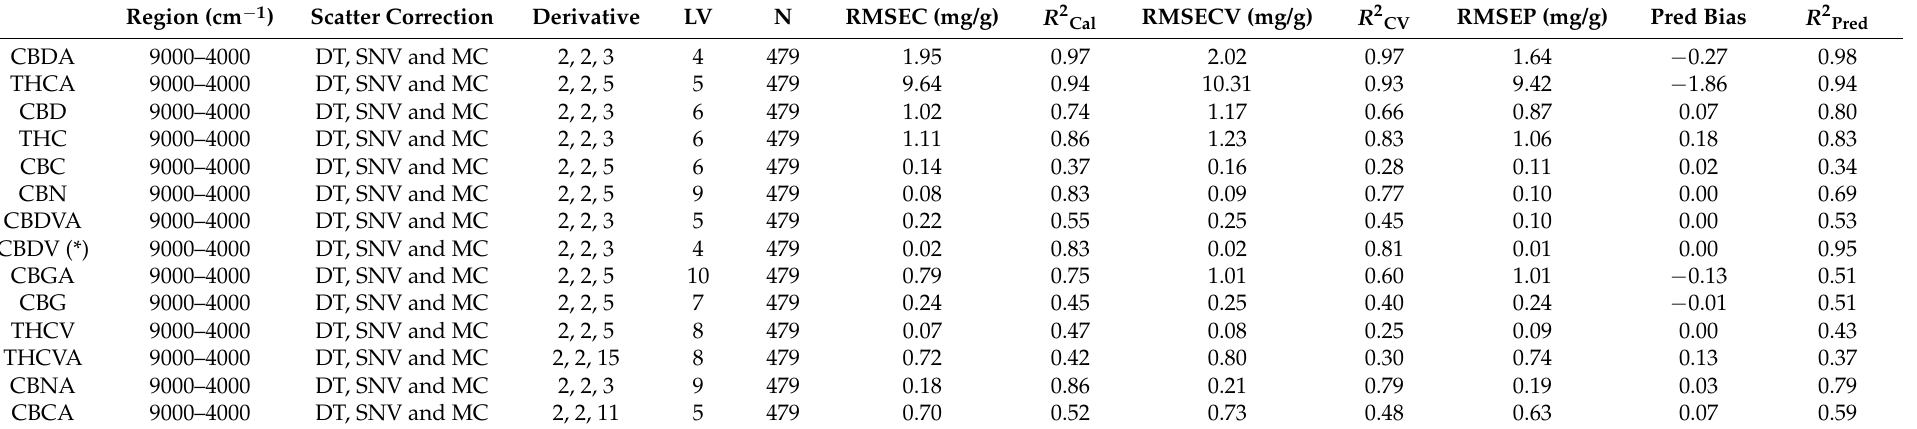
Table 7. Calibration and validation values of partial least squares regression models on coarsely ground cannabinoid compounds analysed by the Bruker MPA II instrument.